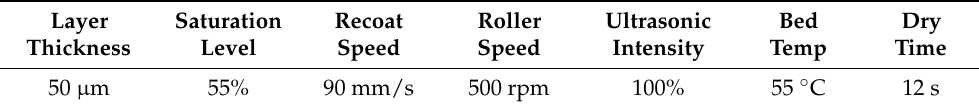
Table 1. Printing parameters used for the fabrication of binder jetting samples.